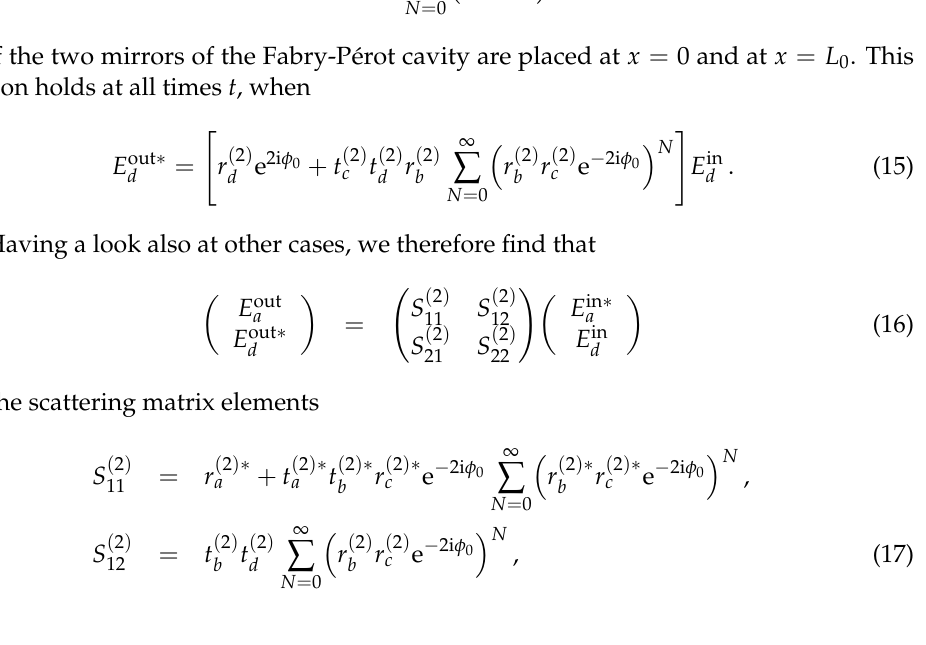
( 2 ) ( 2 ) and t denote transmission i i and E out with i = a , b , c , d denote complex electric field i i